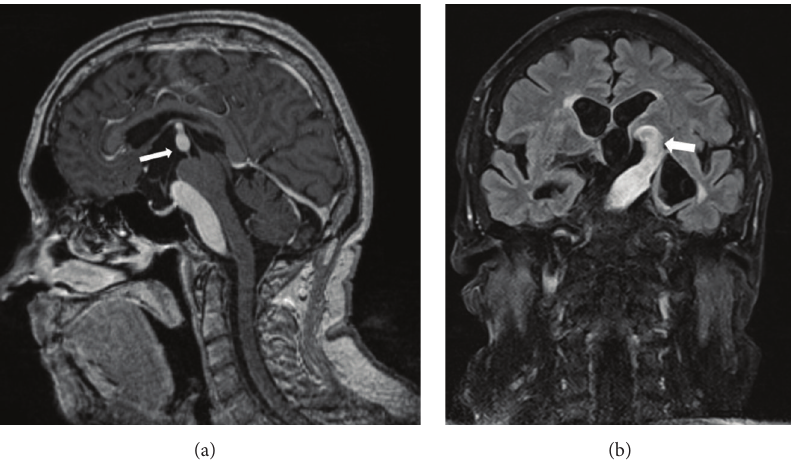
Figure 3: Magnetic resonance imaging (T1-weighted, contrast-enhanced). (a) Midline sagittal view (white arrow depicting dolichoectatic basilar artery elevating the floor of lateral ventricle). Note mass-effect on the brainstem. (b) Marked elevation of left optic tract (white